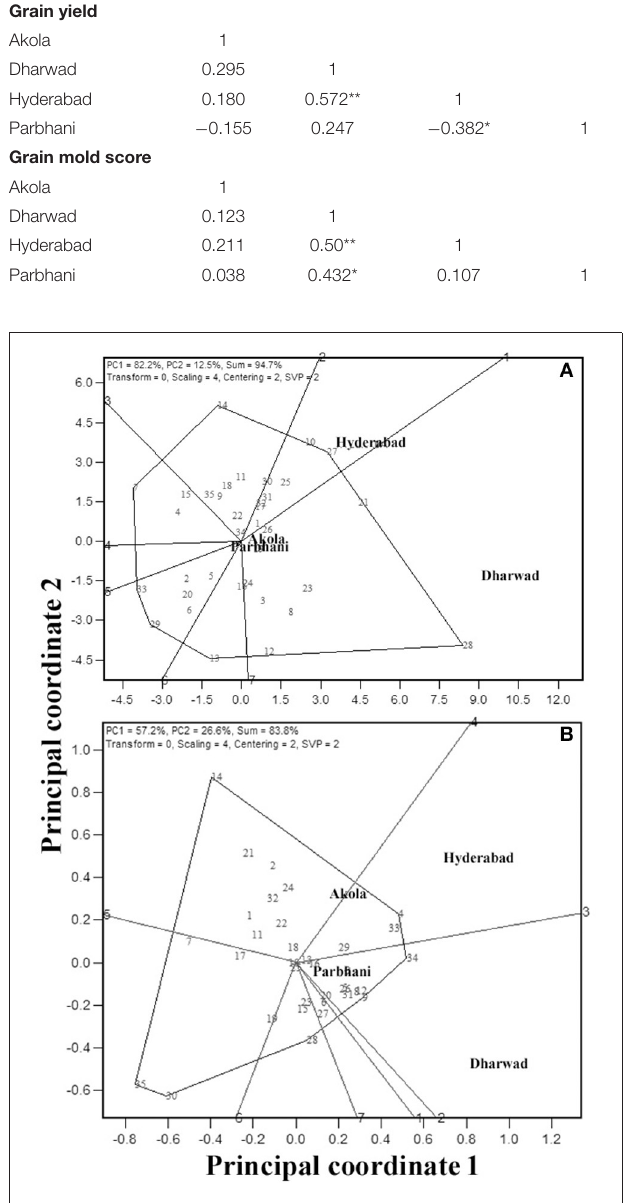
FIGURE 6 | GGE biplot indicating “which-won-where” analysis of the 35 sorghum genotypes for GY (A) and grain mold score (B) .